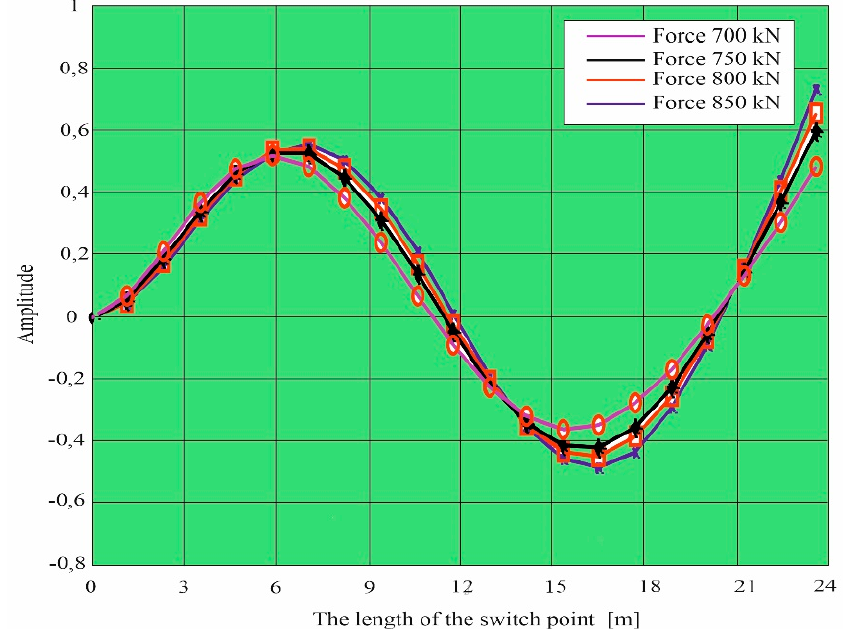
Figure 10. Third own form for a curved beam with a variable cross-section (turnout switch point).